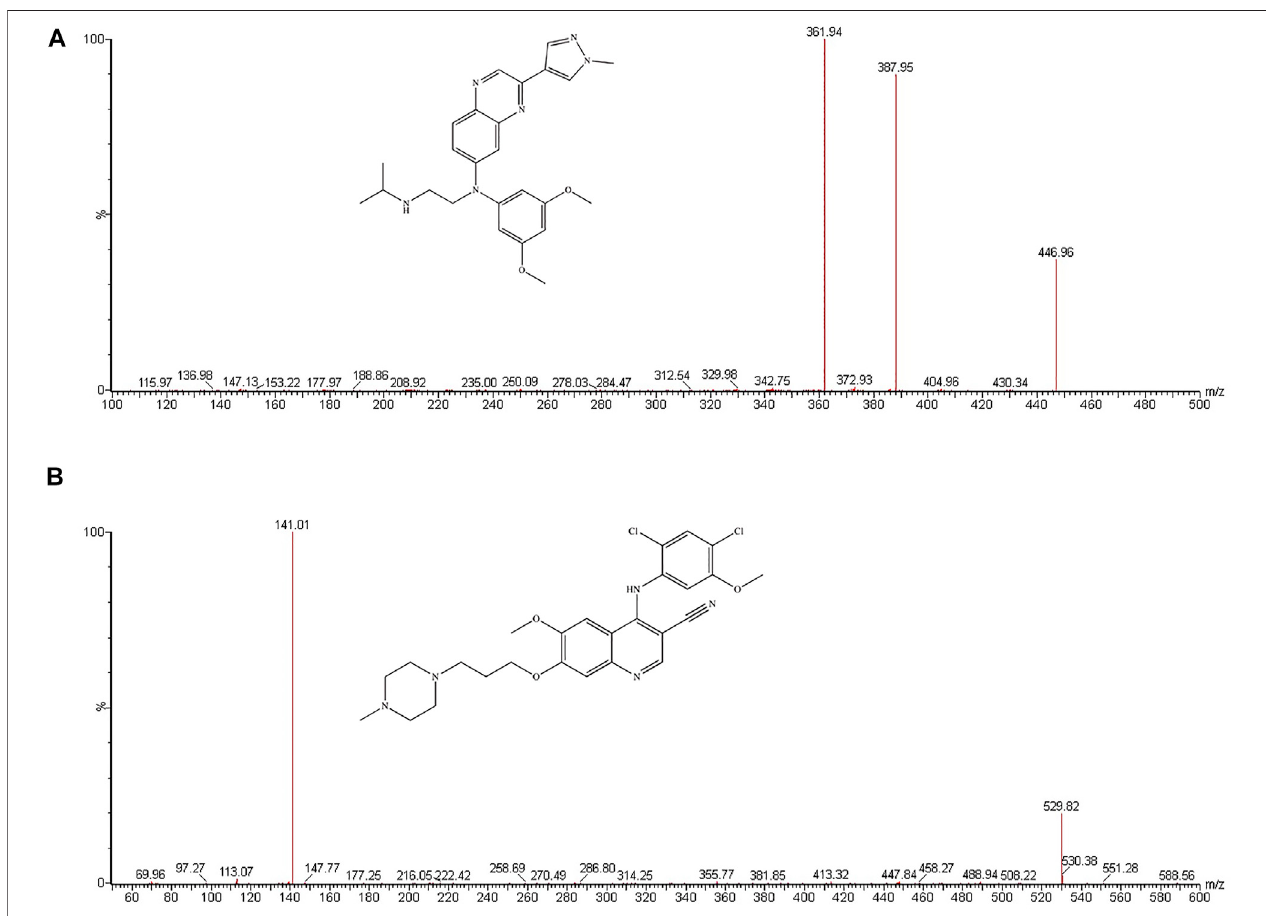
FIGURE 1 | The chemical structure and mass spectra of erda fi tinib (A) and bosutinib IS (B) .